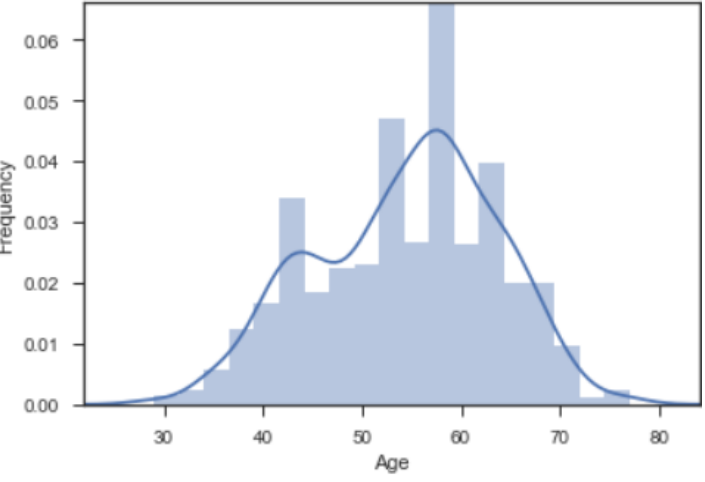
Figure 1. Histogram of